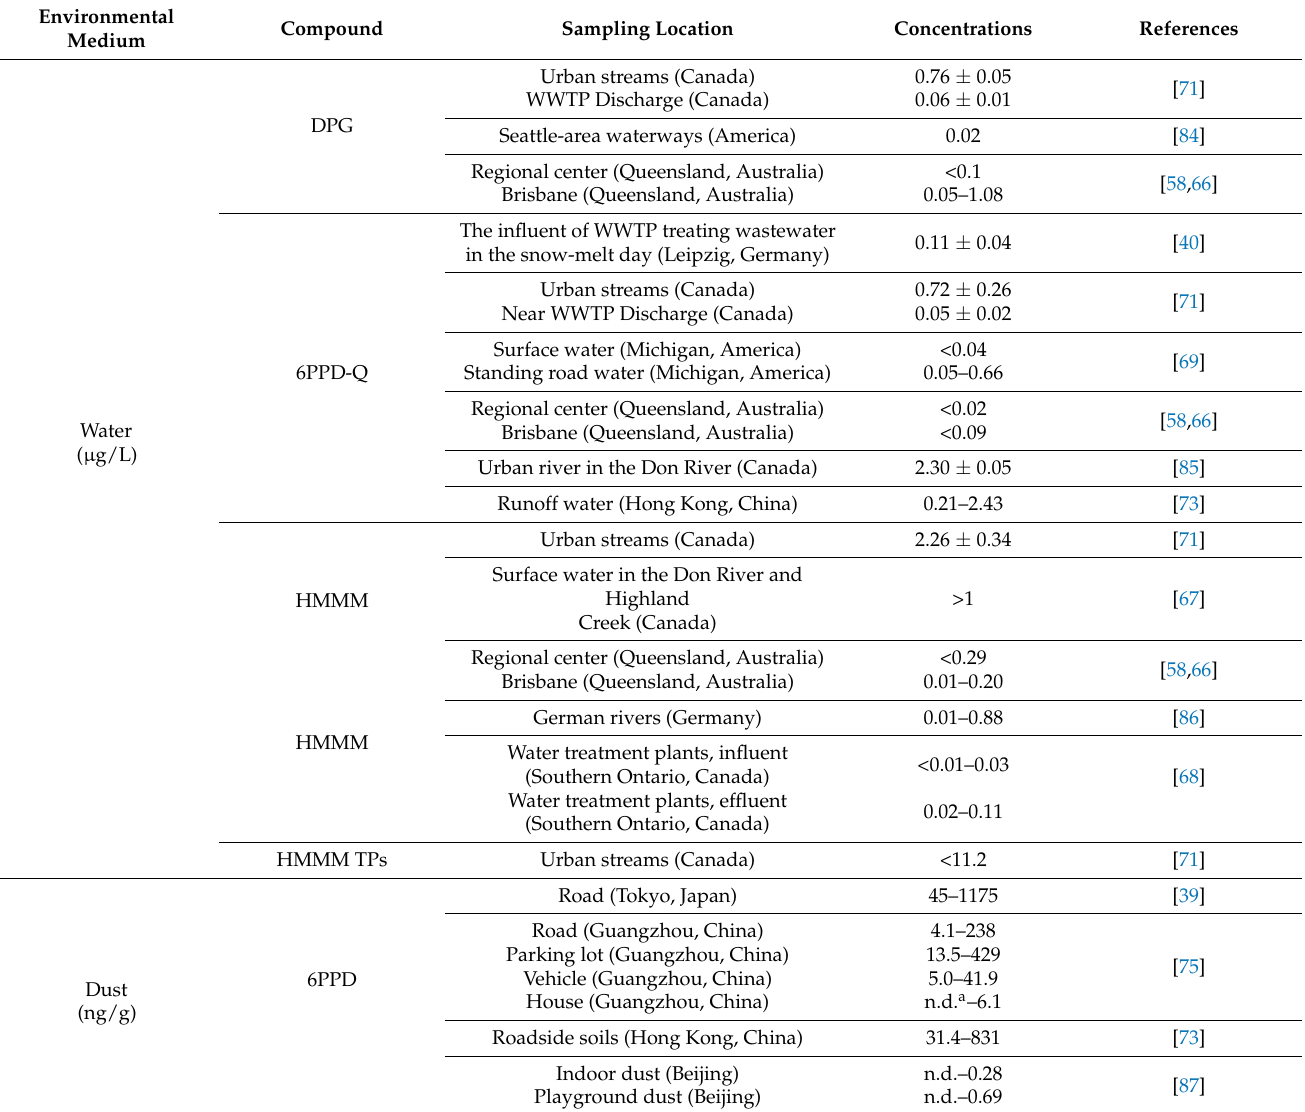
Table 1. The levels of antioxidants and TPs in the different